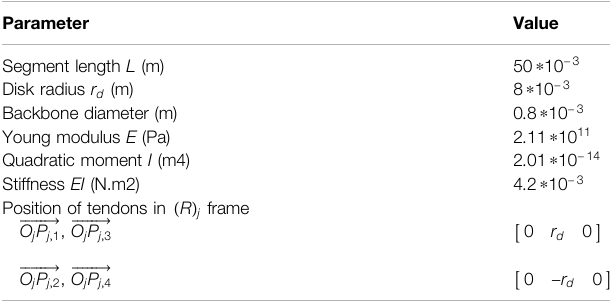
TABLE 3 | Parameters of the TDCR used for the case